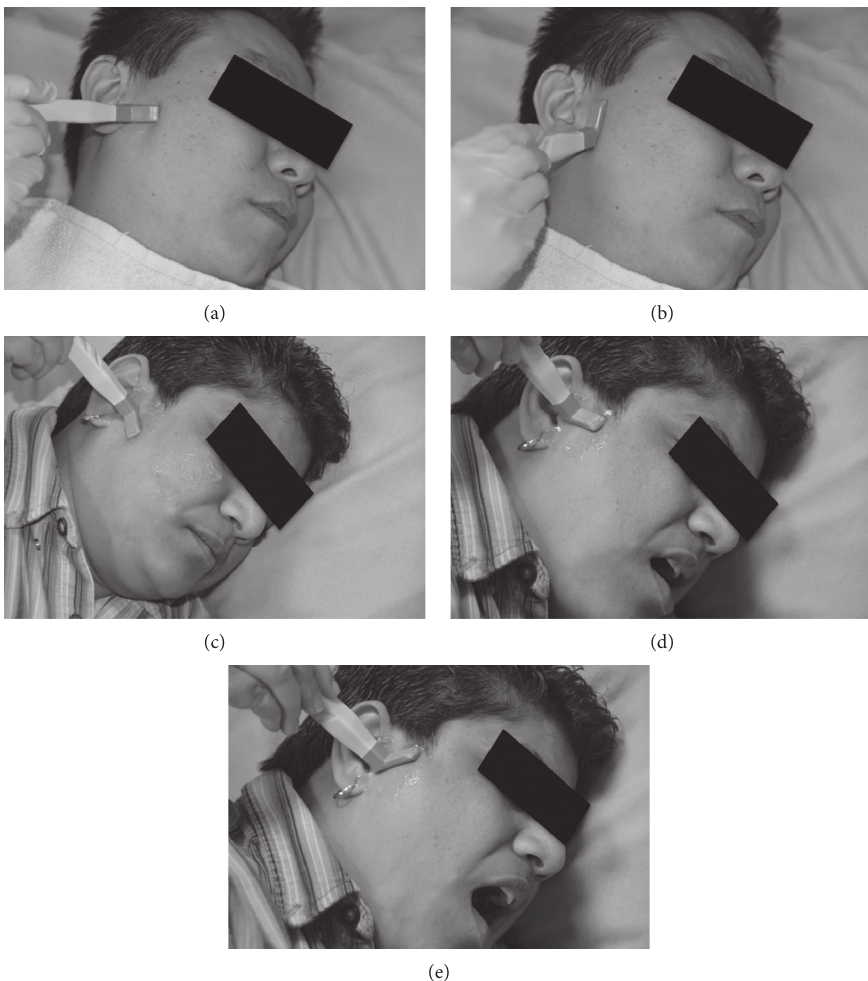
Figure 1: Position of the probe on the skin surface for traditional (a) transverse and (b) coronal scans. The probe position during routine interrogation of the TMJ is (c) angled parallel to the disc in the sagittal plane at 50–60 ° below the horizontal as measured from the anterior side of the probe or 5 o’clock position in the closed-mouth position on the right, (d) angled parallel to the disc or 3 o’clock position in the half-open-mouth position on the right, and (e) angled 50–60 ° above the horizontal as measured from the anterior side of the probe in the fully open-mouth or 1 o’clock position on the right. In a similar manner, these angles represent 7 o’clock, 9 o’clock, and 11 o’clock positions when investigating the TMJ on the